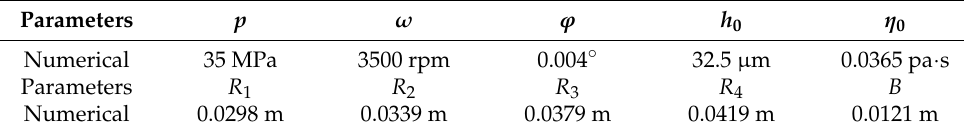
Figure 1. The model of port plate pair for piston pump. ( a ) The assembly diagram of the valve plate and cylinder block; ( b ) A schematic diagram of the valve plate. Table 1. working parameters of the port plate pair.